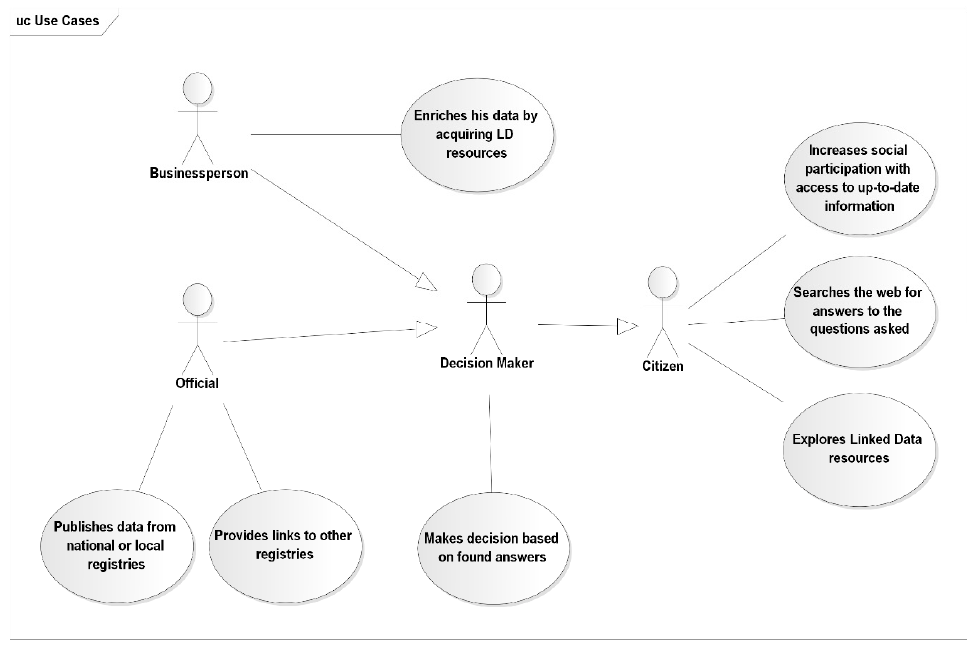
Figure 3. Use cases of the system.